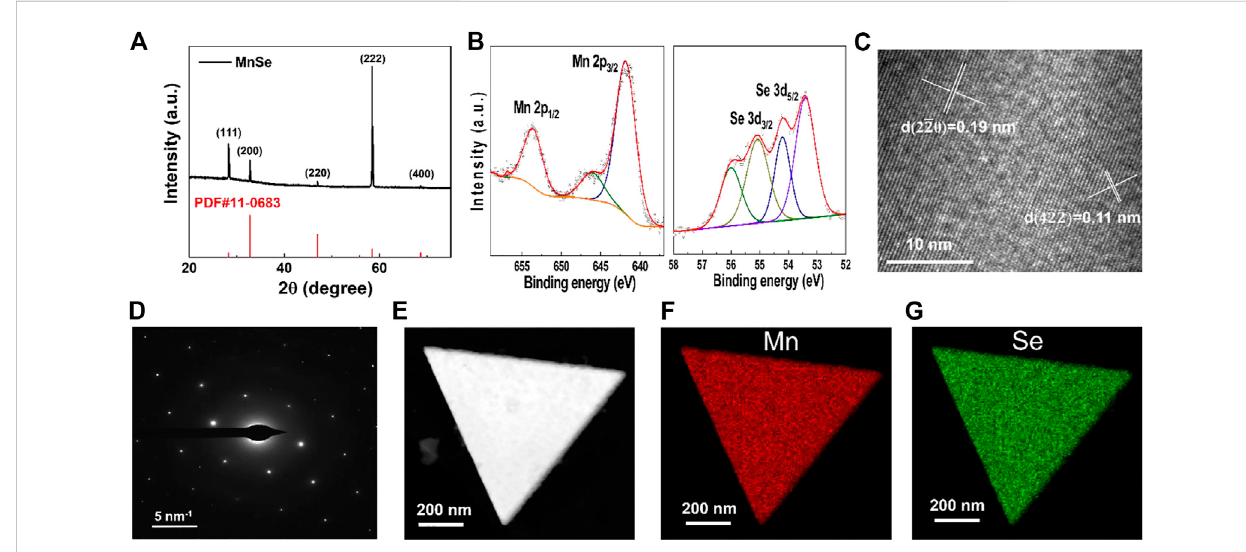
FIGURE 1 Material characterizations of the synthesized MnSe nanosheets. (A) XRD pattern. (B) XPS patterns. (C) HRTEM image and (D) SAED pattern. (E) TEM image. EDS patterns of (F) Mn and (G) Se in the synthesized MnSe nanosheets.